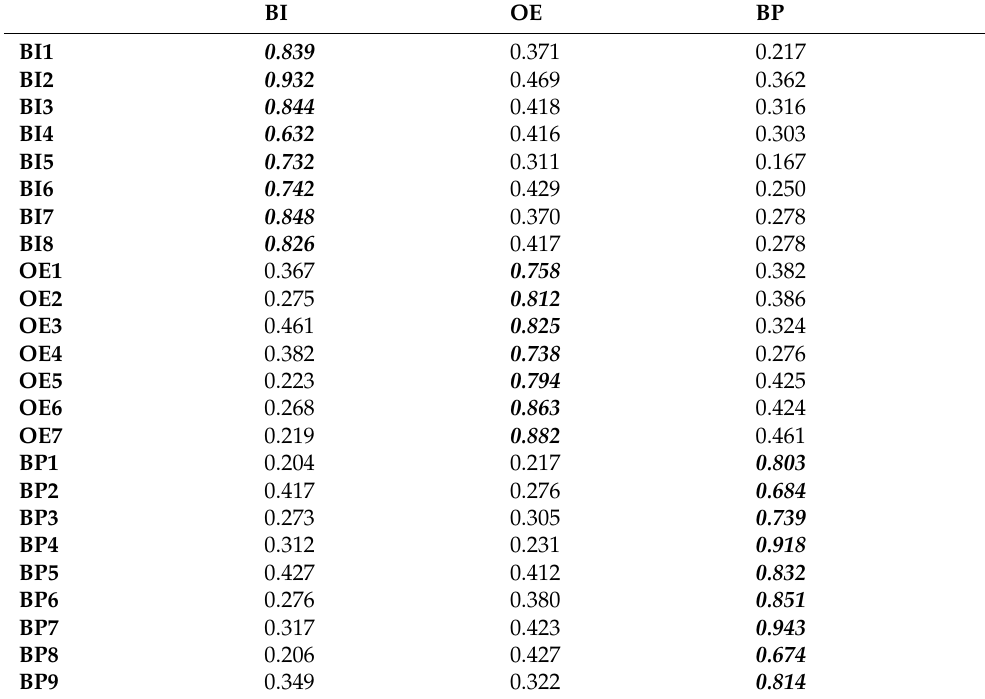
Table 4. Cross loadings.